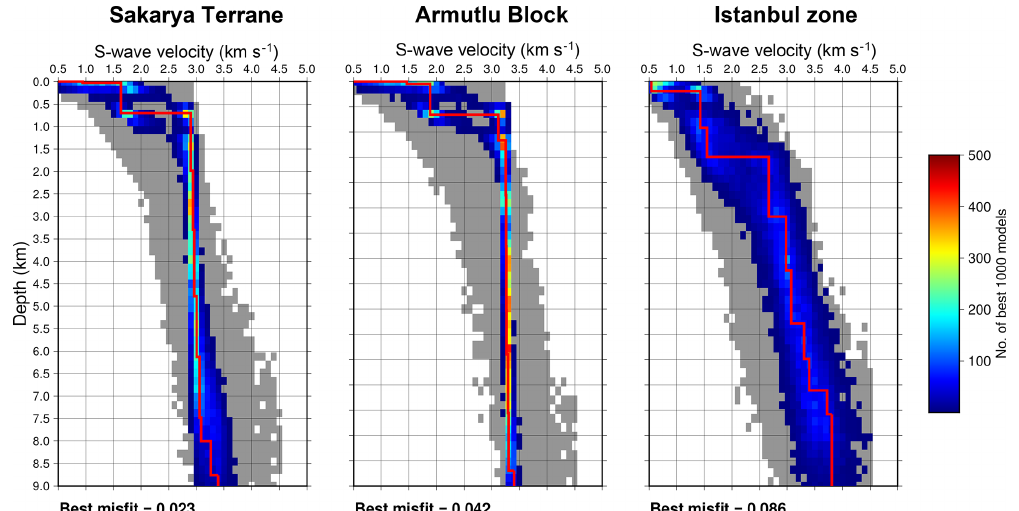
Figure 5. Results of the neighbourhood algorithm inversion for S-wave velocity at three nodes in the different geological units (Fig. 1). The grey region represents the range of accepted models with a misfit below 0.25 (Eq. 3). The coloured region shows the range of the 1000 models with the lowest misfit. Red colours indicate a higher number of the best 1000 models with a certain S-wave velocity at that depth. The solid red line shows the best-fitting model, the misfit of which is shown at the bottom of each panel. The location of each of these nodes is shown in Fig.